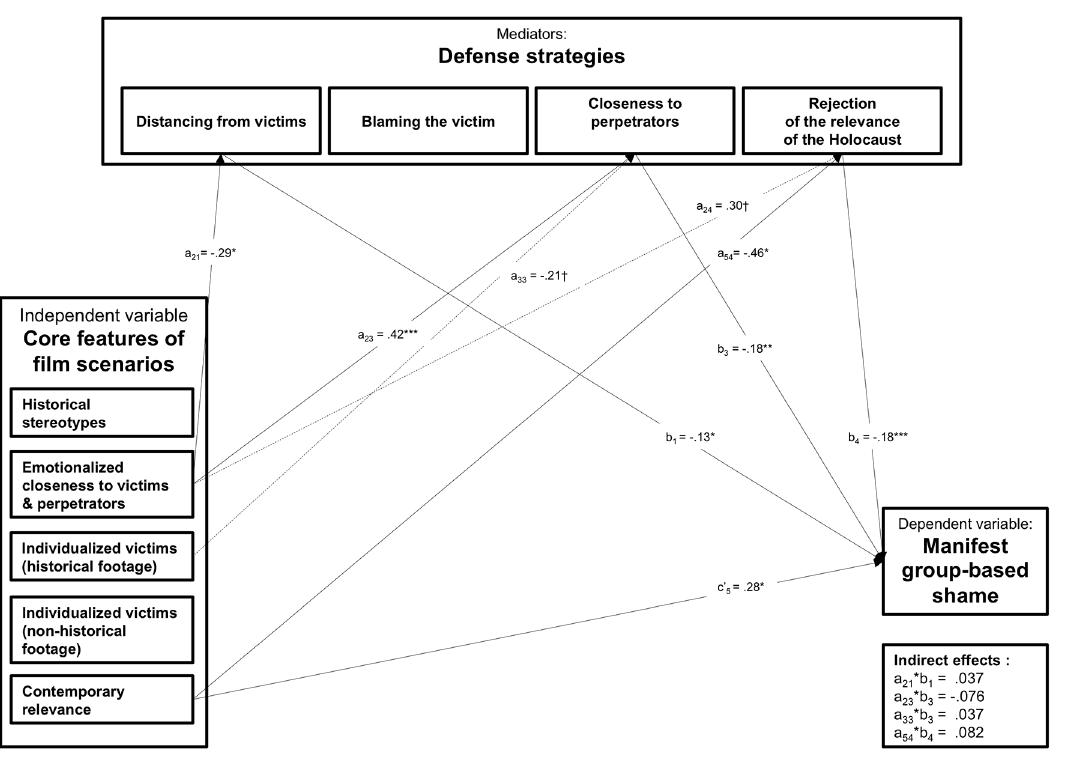
Figure 1. Multiple mediation model of group-based shame reactions. Control variables (age, gender, national identification, and region (East- /West-Germany)) are omitted in this